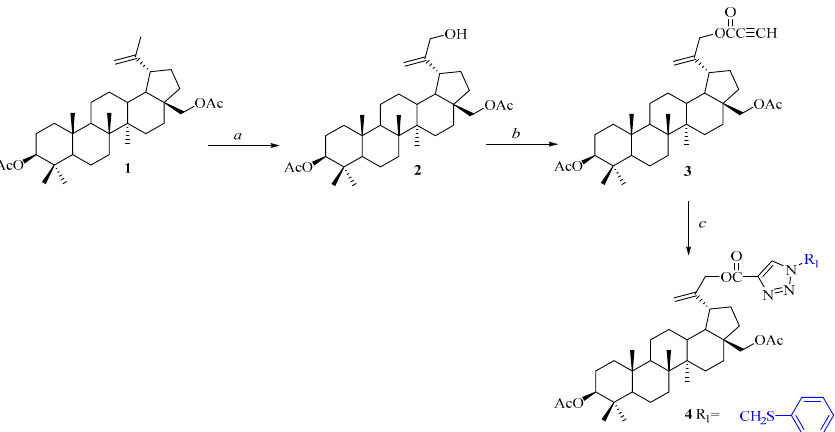
Figure 3. Molecular packing of unit cell for 4 . The six-membered rings of betulin scaffold adopt chair conformation. The cyclopen- tane ring assumes conformation of the twisted envelope. The torsion angle C19-C20-C29- C30 describing the orientation of the isopropenyl group arrangement in relation to the five-membered ring of 4 is equal to −176.50°. The introduction of large substituent at the C-30 position in 4 caused a significant change in the arrangement of this group compared